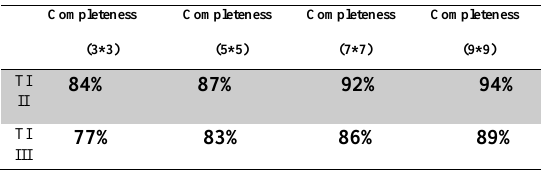
Figure 8. (Test Image III) Results of algorithm on various satellite images. 8(a) Original Images; 8(b) Raster map of centerline; 8(c) Vector map of centerline. Table 2. Performance measures of proposed methodology with different